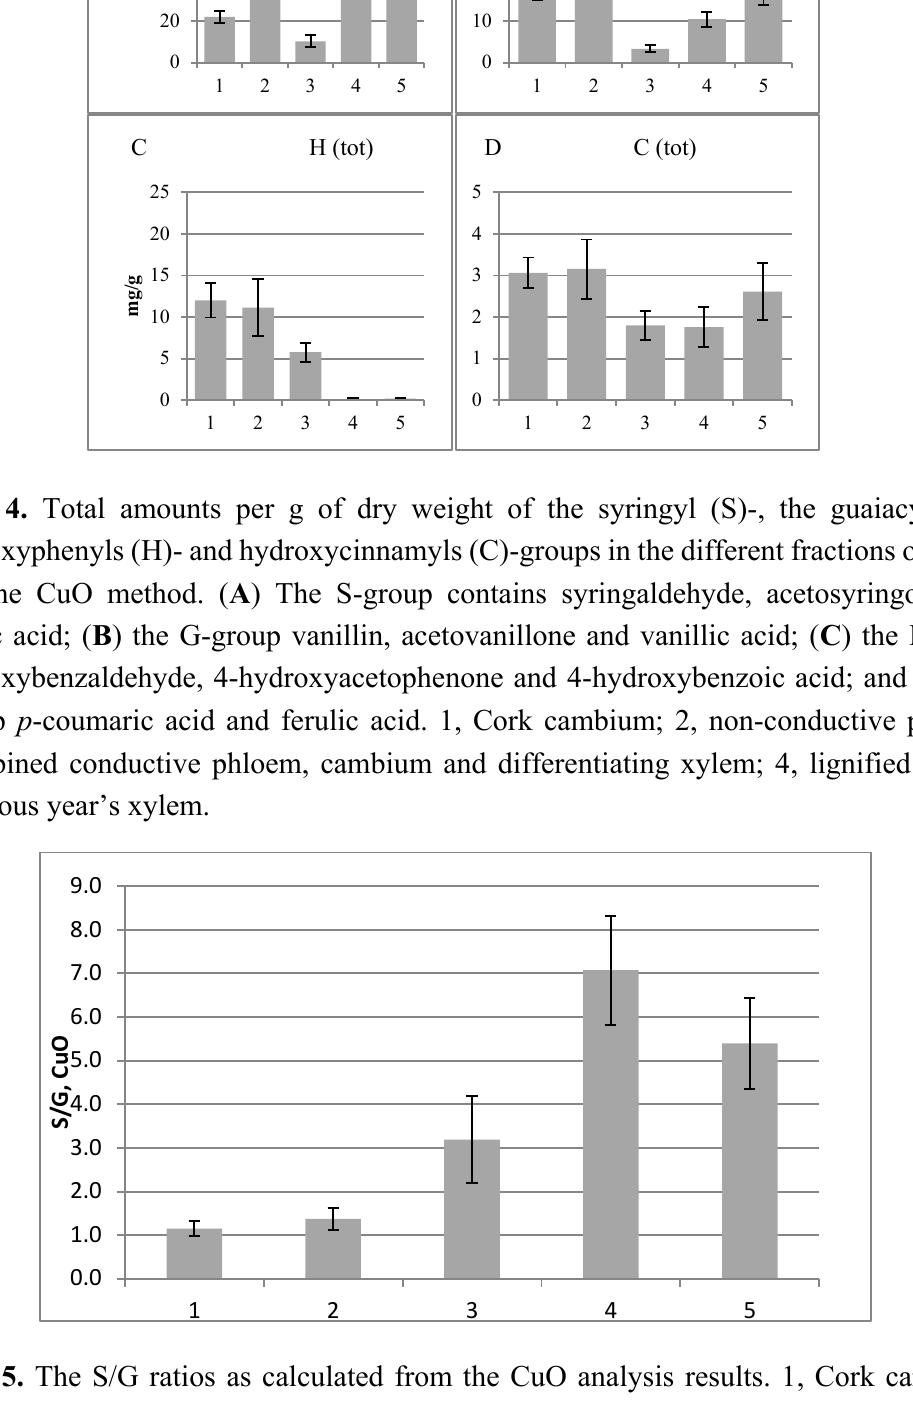
Figure 5. The S/G ratios as calculated from the CuO analysis results. 1, Cork cambium; 2, non-conductive phloem; 3, combined conductive phloem, cambium and differentiating xylem; 4, lignified xylem; 5, previous year’s